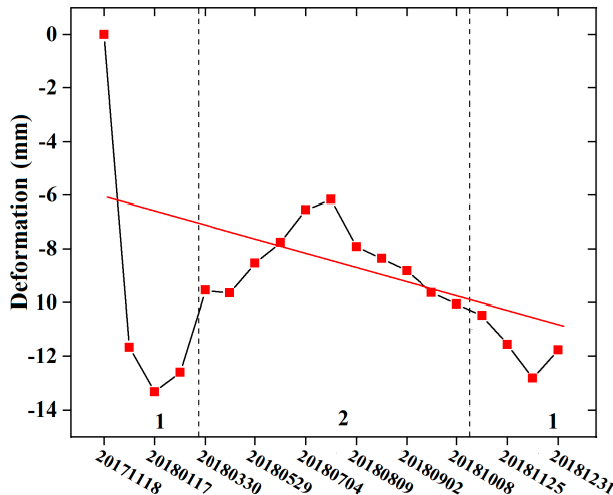
Figure 9. Trend of glacier deformation in the study area. Period 1 refers to winter and Period 2 refers to summer.